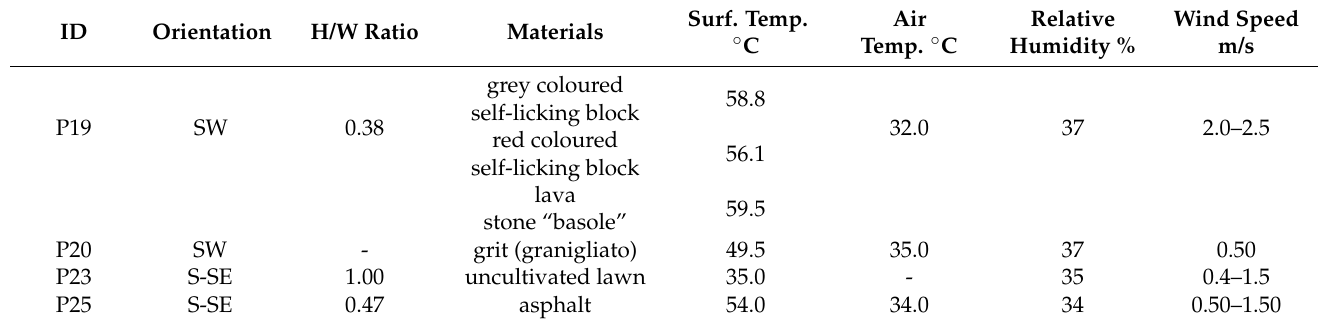
Table 2. Environmental data extract from the Ponticelli district area (July 2015,